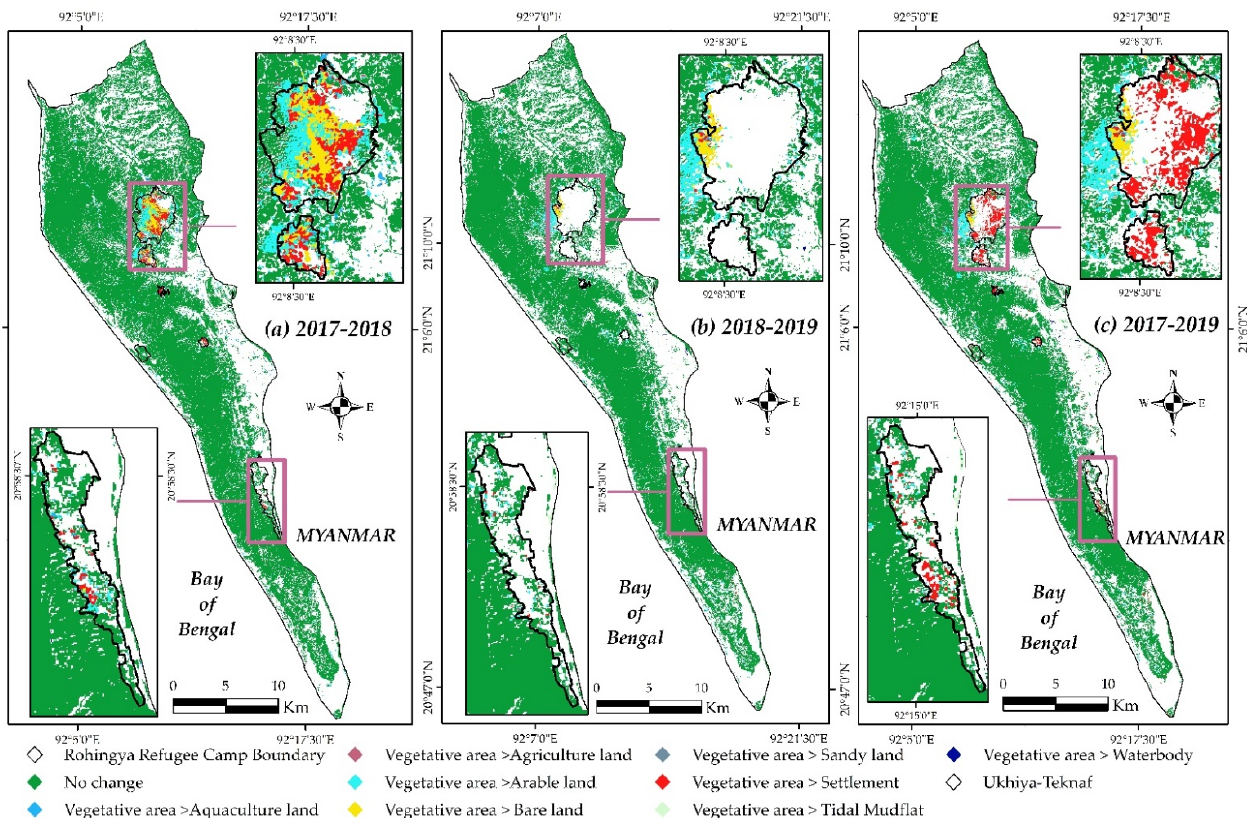
Figure 13. The transition of vegetation covers to other land use/land cover, Ukhiya-Teknaf. ( a ) 2017–2018, ( b ) 2018–2019, and ( c ) 2017–2019.